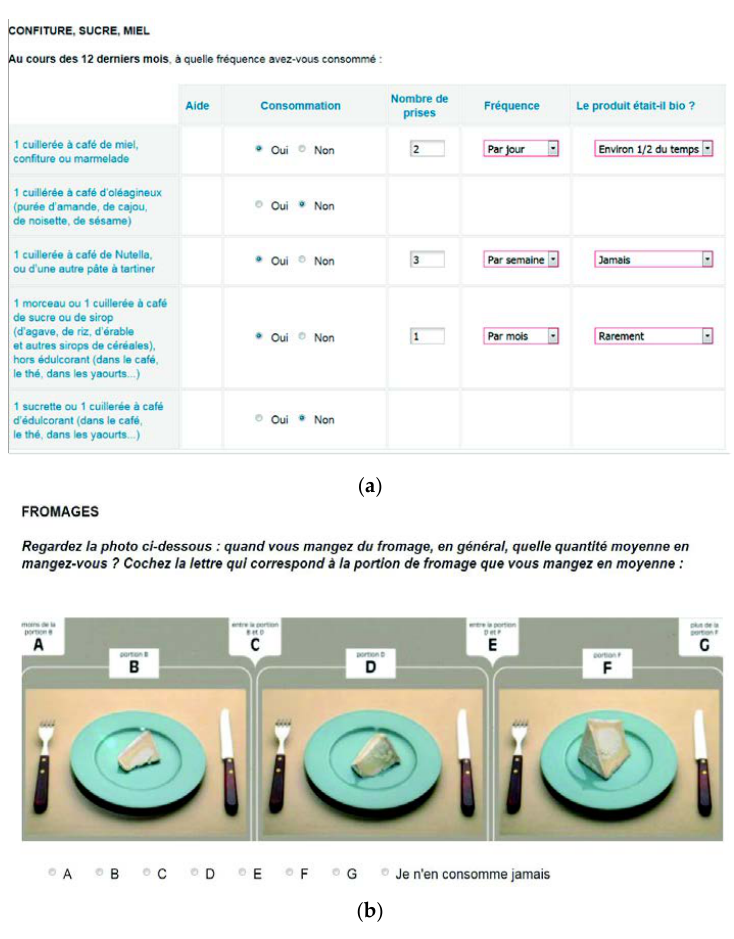
Figure 1. Extracts of the Org-FFQ, NutriNet-Santé Study, N = 28,245; ( a ) For each food item consumed, the quantity, the frequency of the intake and the relative organic share were asked; ( b ) For eight categories which are usually not eaten in a predetermined portion size, the questionnaire included sets of colour photographs.